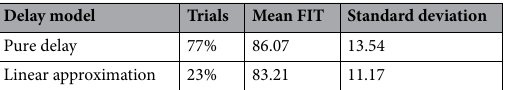
Table 3. Comparison of pure delay and linear approximation.